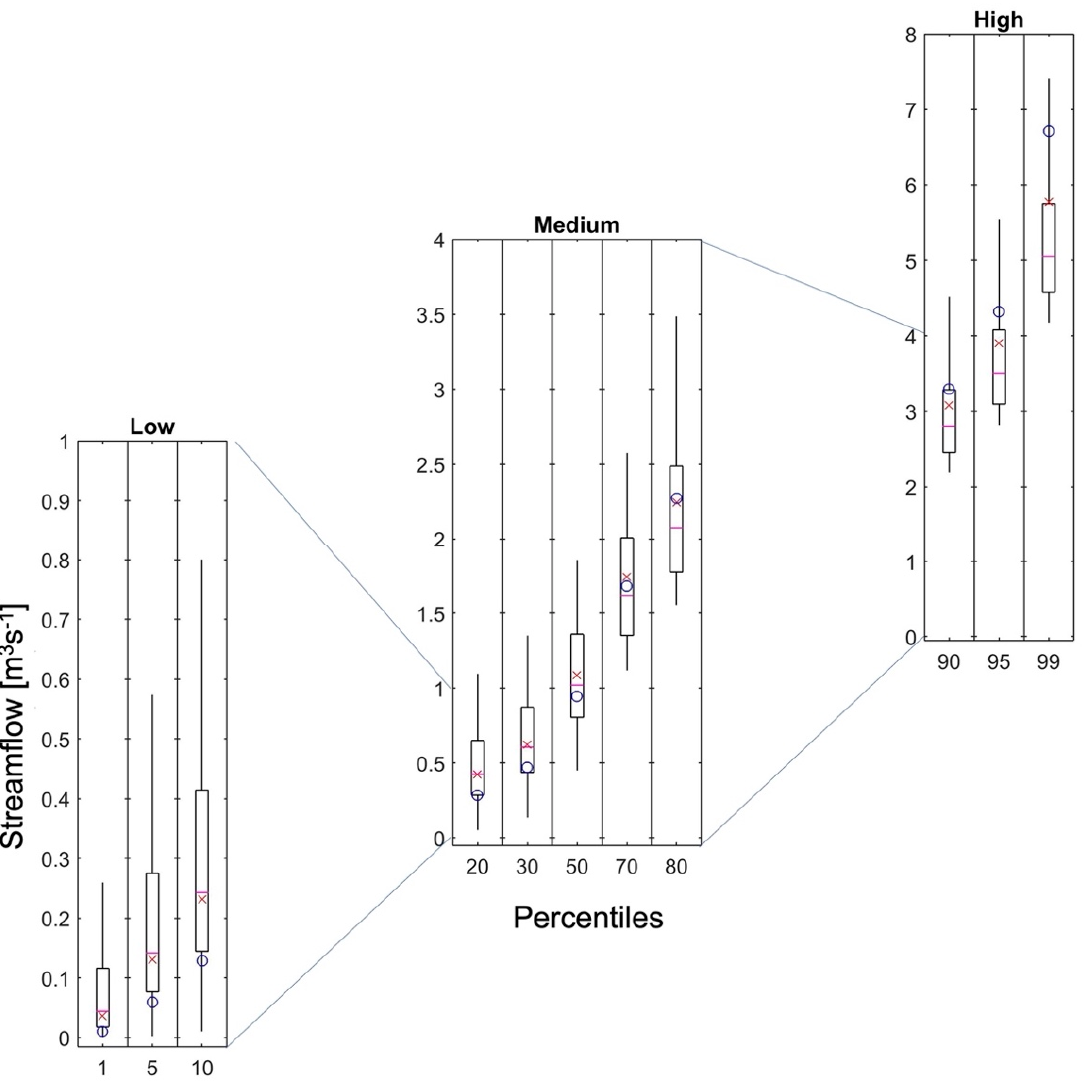
Figure 7. Flow regimes of simulated monthly streamflow using rain gage forcings, from 1950 to 2010. Boxes represent lower (25th), medium (50th), and upper (75th) quartiles, while whiskers represent the 5th and 95th interquartile. Best simulated flow (x) and observations (o).